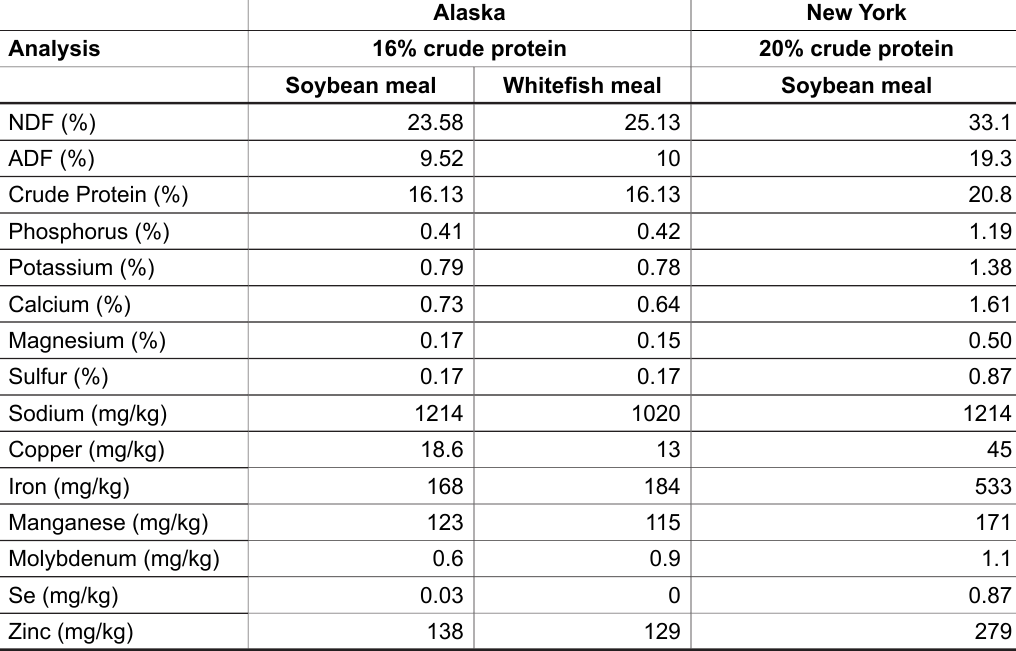
Table 1. Nutritional profile of two of the feed mixes fed to the Alaska Reindeer Research Program captive deer and for the New York herd, on an as-fed